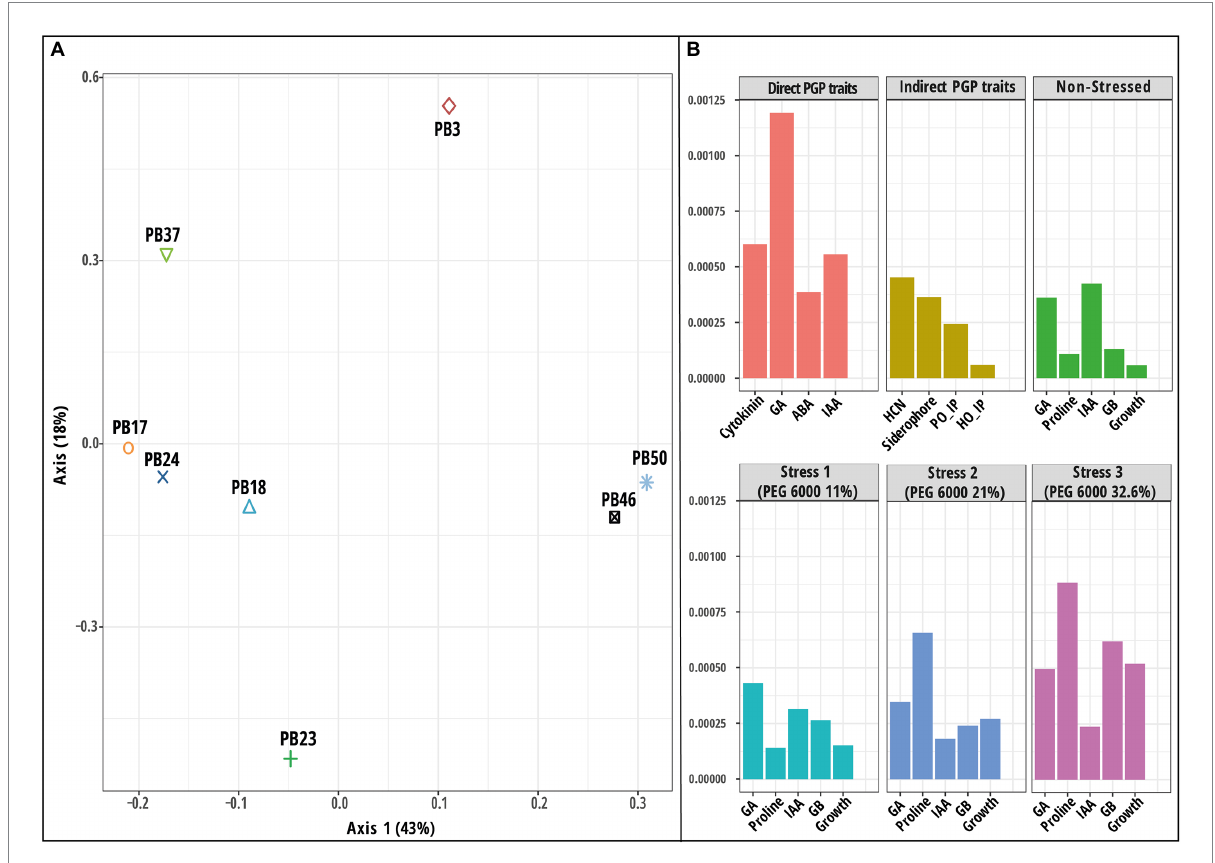
FIGURE 6 Results of multiple kernel learning analysis (MKL). (A) A plot of kernel principal component analysis (KPCA) based on six datasets (direct plant growth-promoting (PGP) traits, indirect PGP traits, microbial parameters under osmotic stress at polyethylene glycol (PEG) concentrations 0, 11, 21, and 32.6%). (B) A plot for important variables in each dataset assessed using the Crone-Crosby distance. The codes of the strains in plot (A) refer to the following strains: Bacillus endophyticus PB3, B . australimaris PB17, B . pumilus PB18, B . safensis PB23, Staphylococcus sciuri PB24, B . altitudinis PB37, B . altitudinis PB46, and B . megaterium PB50. Abbreviations used in plot (B) are indoleacetic acid (IAA), gibberellic acid (GA), abscisic acid (ABA), hydrogen cyanide (HCN), Helminthosporium oryzae inhibition percentage (HO_IP), and Pyricularia oryzae inhibition percentage